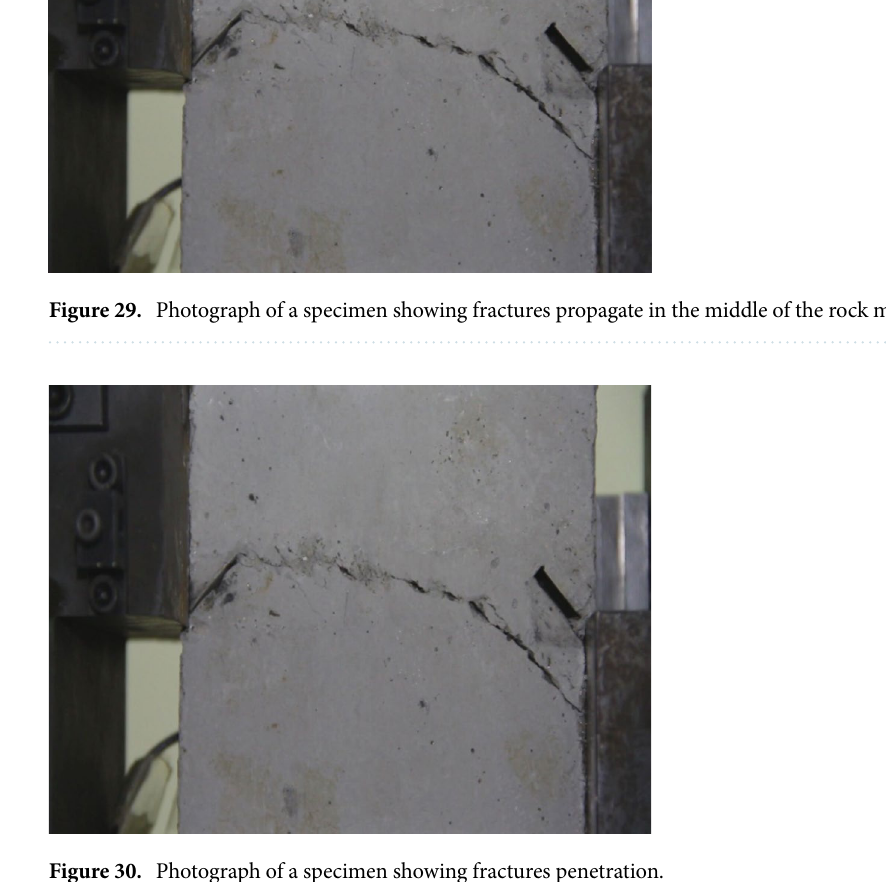
Figure 30. Photograph of a specimen showing fractures penetration.